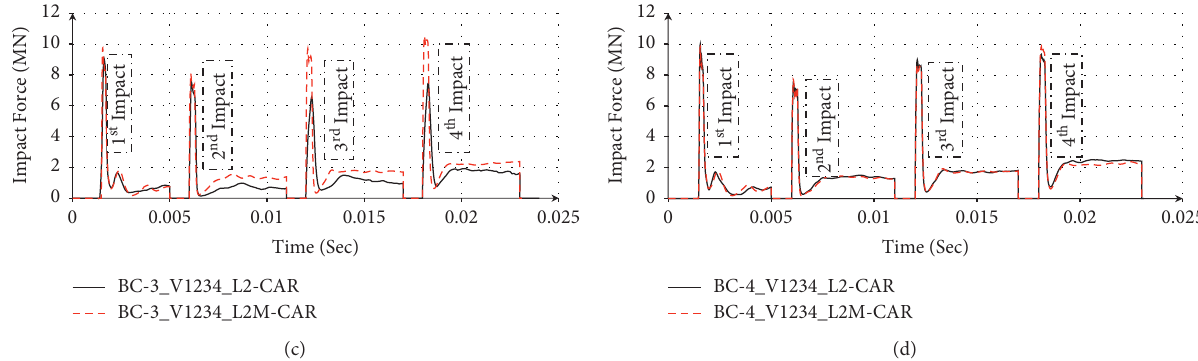
Figure 17: Influence of impact location on impact behavior of BRC columns. (a) Without bundle reinforcement distribution. (b) Two- bundle reinforcement distribution. (c) Three-bundle reinforcement distribution. (d) Four-bundle reinforcement